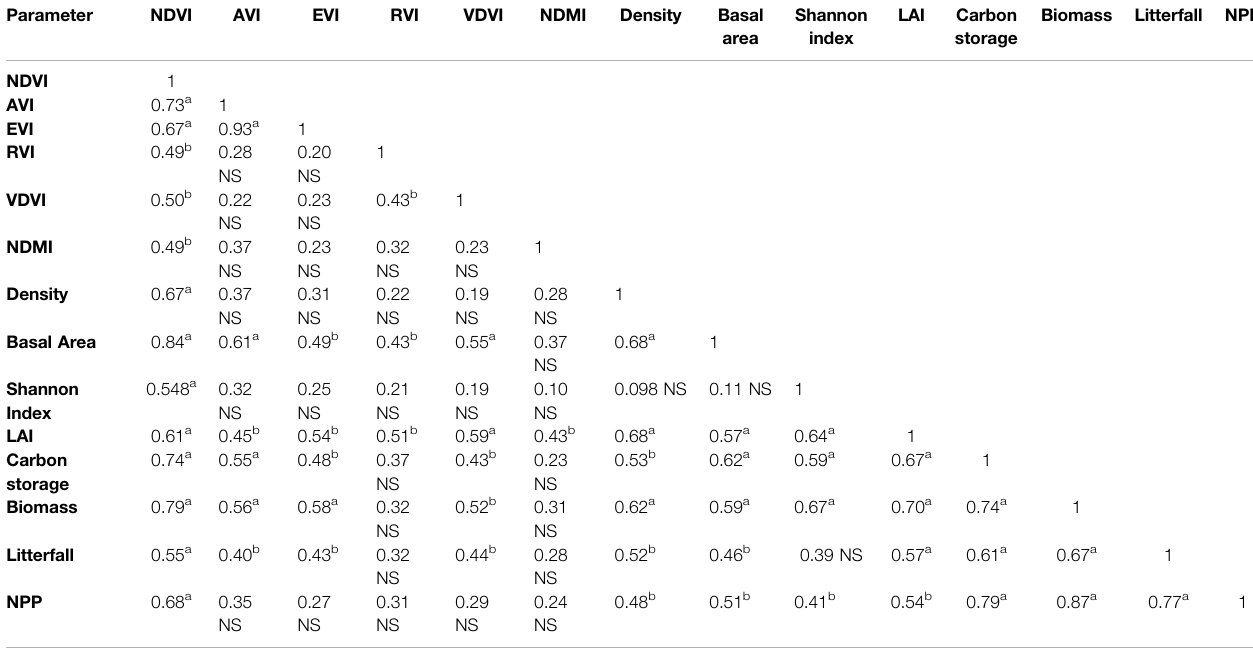
a Correlation is signi fi cant at the 0.01 level (2-tailed). b Correlation is signi fi cant at the 0.05 level (2-tailed). NS denotes non-signi fi cant.